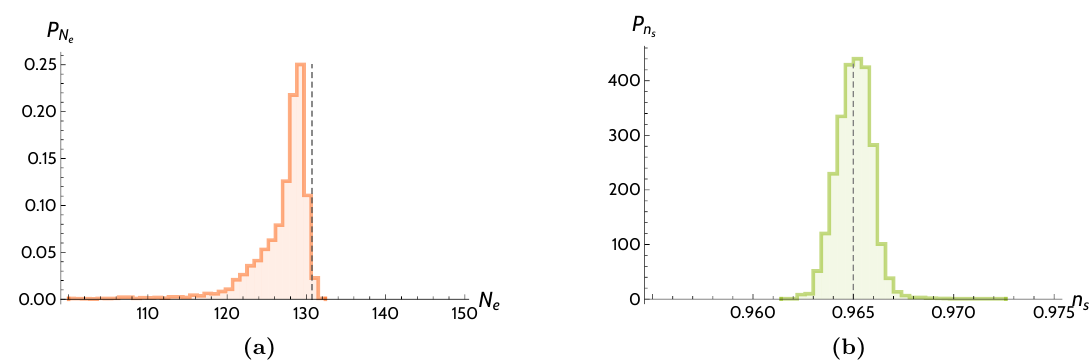
Figure 10. (a) Distribution of number of e-folds, with N exp shown with a dashed line (b) Histogram of the obtained spectral index, with the analytic prediction marked with a dashed line. Both (cid:12)gures represent 4000 in(cid:13)ationary trajectories (see